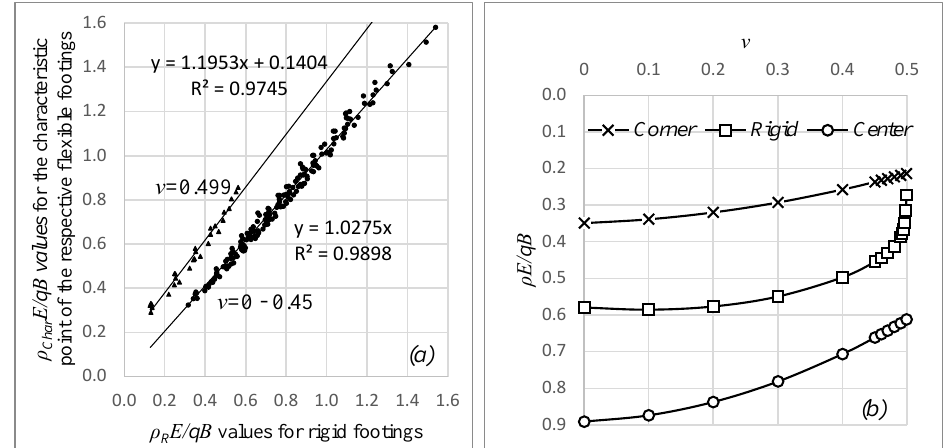
Figure 10. ( a ) ρ R Ε/Β values for rigid footings vs. ρ Char Ε/ q Β values for the characteristic point of the respective flexible footings (chart drawn based on 210 different cases); ( b ) ρΕ/qΒ vs. ν chart for L/B =1 and H/B =2 (the maximum ν value for the rigid footing considered was 0.499).